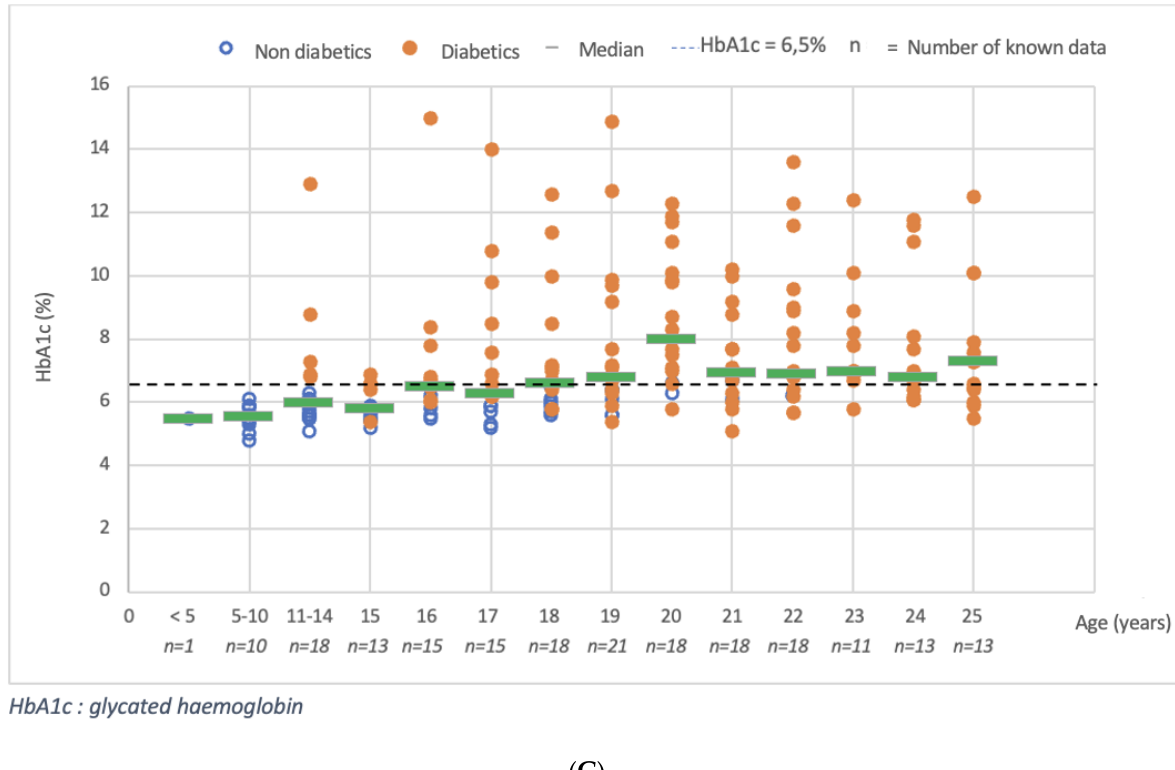
Figure 2. Age at diagnosis and evolution in glucose parameters as a function of age in the population. ( A ): Repartition of patients according to age at diabetes diagnosis ( n = 38). ( B ): Fasting blood glucose (mmol/L) according to age. The open circle represents plasma glucose levels before diagnosis of T2DM and the full circle represents glucose levels after diagnosis of T2DM. The horizontal line represents the median value. The dotted line represents the cut-off value of 7 mmol/L. n below the x axis represents the number of values available at each age. ( C ): HbA1c (%) according to age. The open circle represents HbA1c values before diagnosis of T2DM and the full circle represents HbA1c values after diagnosis of T2DM. The horizontal line represents the median value. The dotted line represents the cut-off value of 6.5%. n below the x axis represents the number of values available at each age.